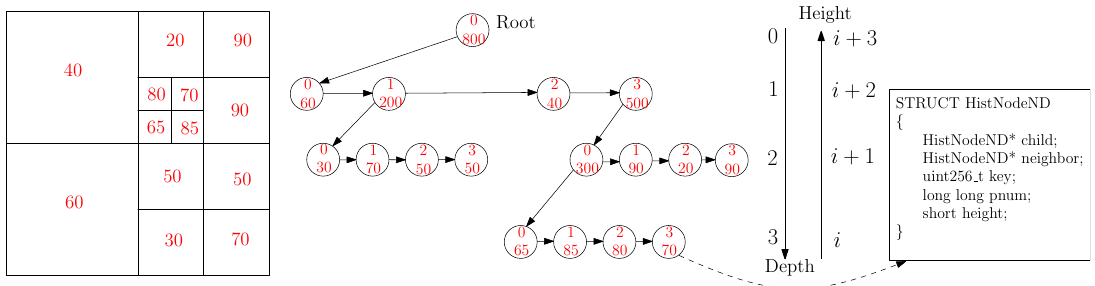
Figure 2. The loading and querying procedure of PlainSFC, divided by the dash line